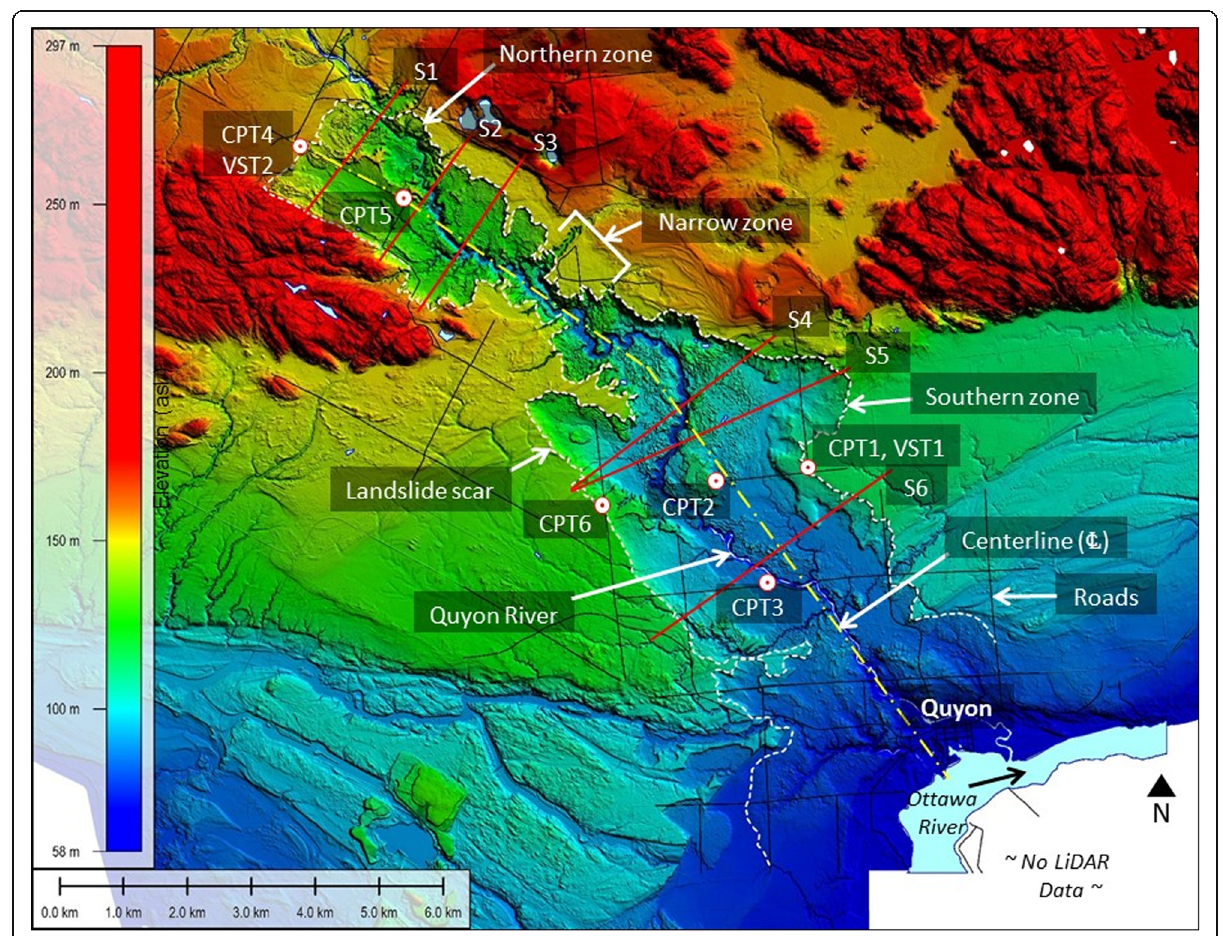
Fig. 4 Study area and shaded relief map of the Quyon landslide (LiDAR image© Government of Quebec. Yellow dash-dotted line marks the approximate centerline of the failure zone where longitudinal failures are analyzed. Red lines are locations where the lateral sections are